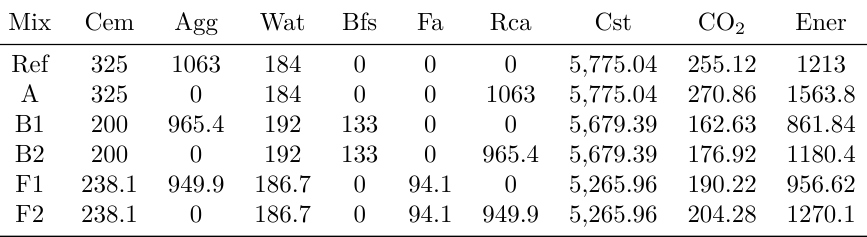
Table 7. Concrete mix characteristics (units are shown in Table 5).